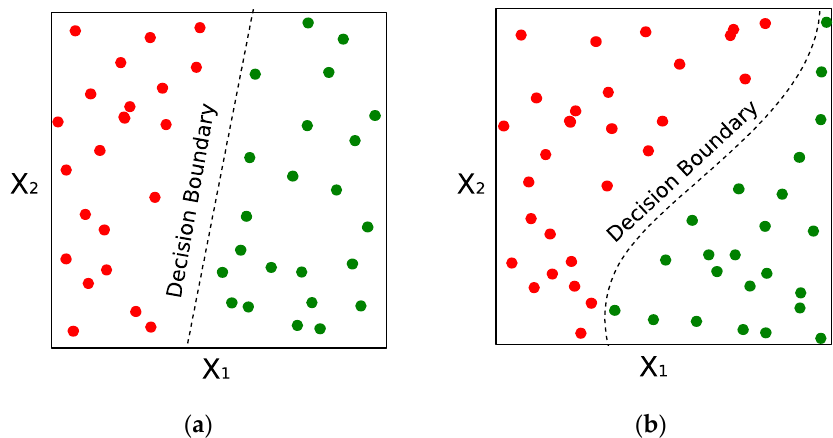
Figure 5. Linear and nonlinear classification boundary in 2D: ( a ) Linear Boundary on separable data; and ( b ) Nonlinear Boundary on separable data.